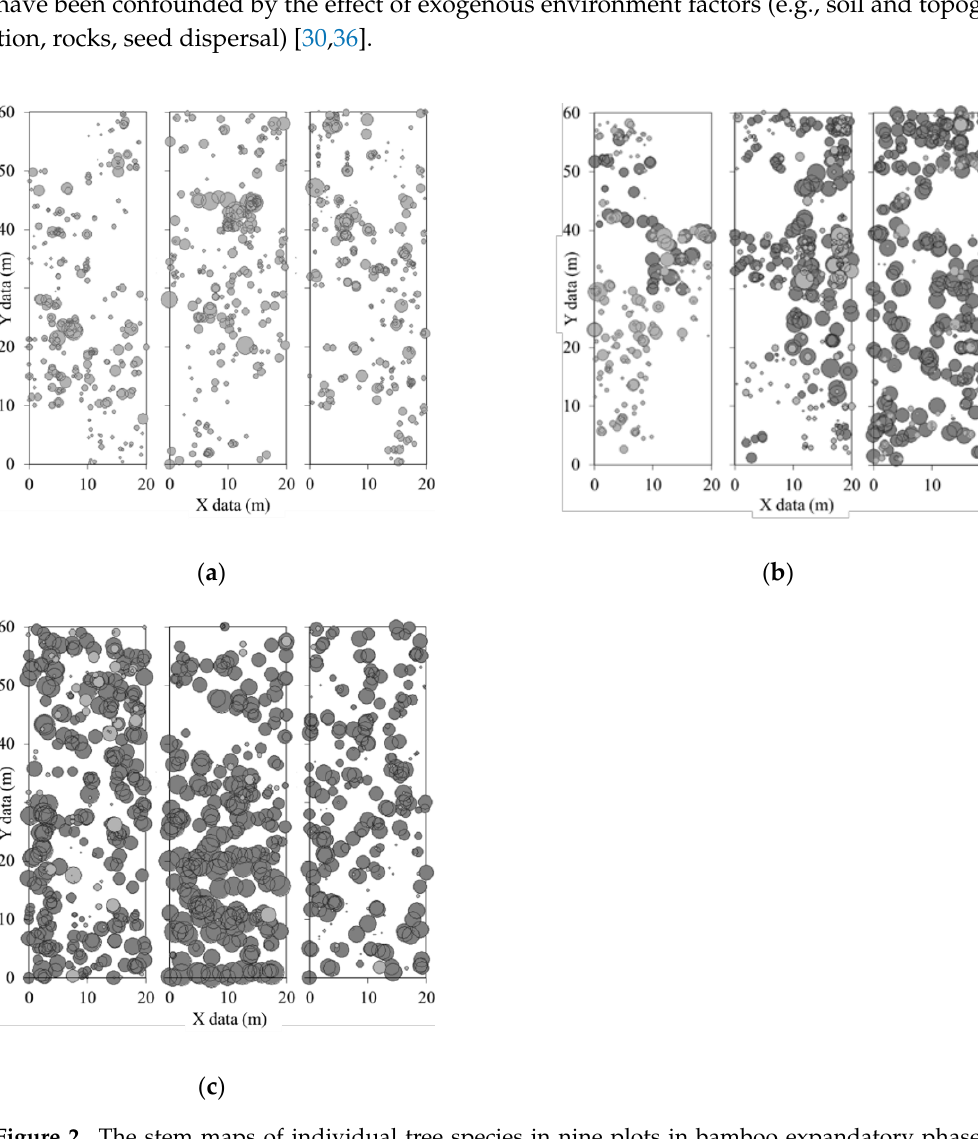
Figure 1. Location of study area and 3D sketch map of study plot. These maps were produced by